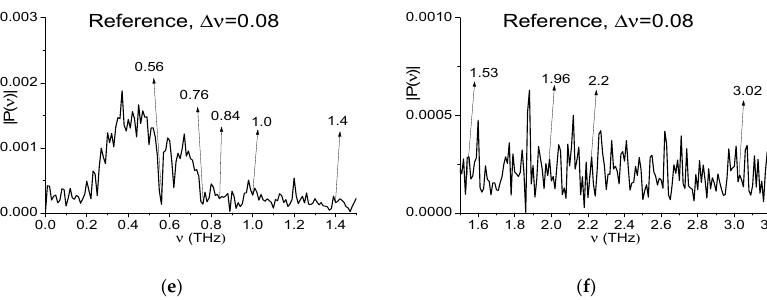
Figure 3. Fourier spectrum ( a , b ), absorbance ( c , d ) of the signal Chocolate and Reference spectrum ( e , f ) in the frequency ranges ν = [0, 1.5] THz ( a , c , e ) and [1.5, 3.2] THz ( b , d , f ) calculated with spectral resolution Δ ν = 0.01 THz.